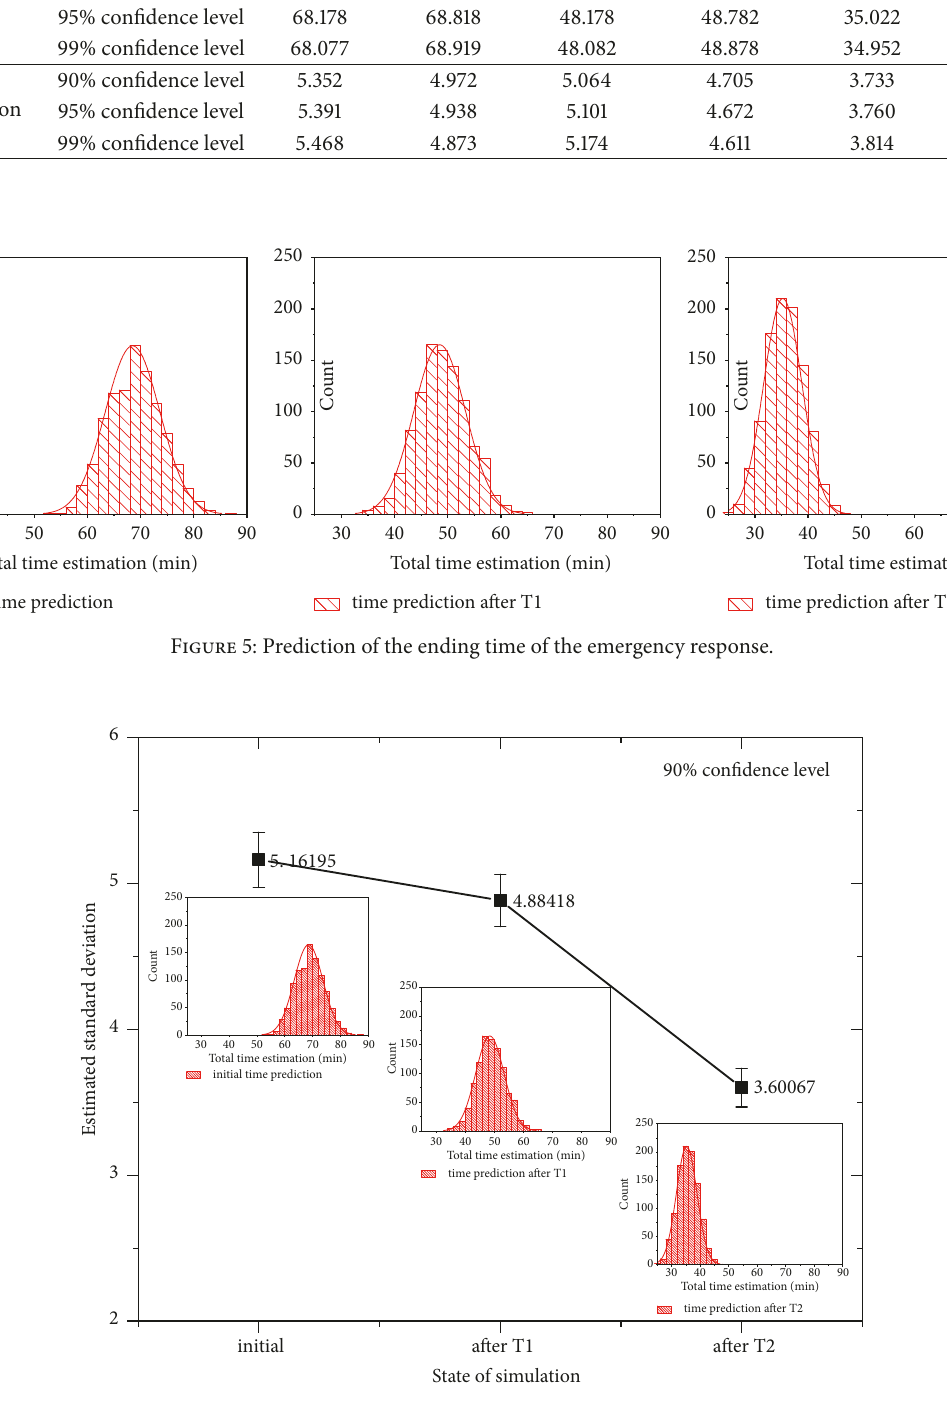
Figure 6: Estimation of the disposal time varying with the emergency stage (90% confidence